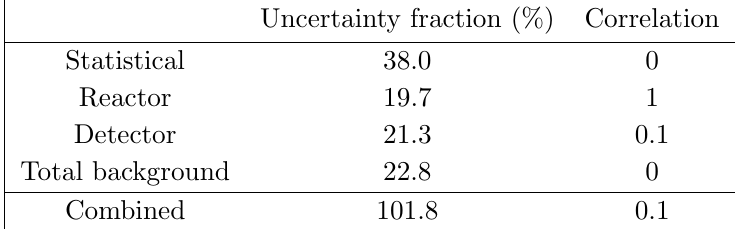
Figure 19 . Top: comparison of the observed (dots) and no-oscillation predicted (blue shaded histogram) IBD prompt spectra in the far detector. The no-oscillation prediction is obtained from the measurement in the near detector. The prediction from the best-(cid:12)t oscillation amplitude is also shown (yellow shaded histogram). Bottom: ratio of observed spectrum in the far detector to the no-oscillation prediction (dots), and the ratio from the MC simulation with the best-(cid:12)t results folded in (shaded band). Errors include the statistical and background subtraction uncertainties.